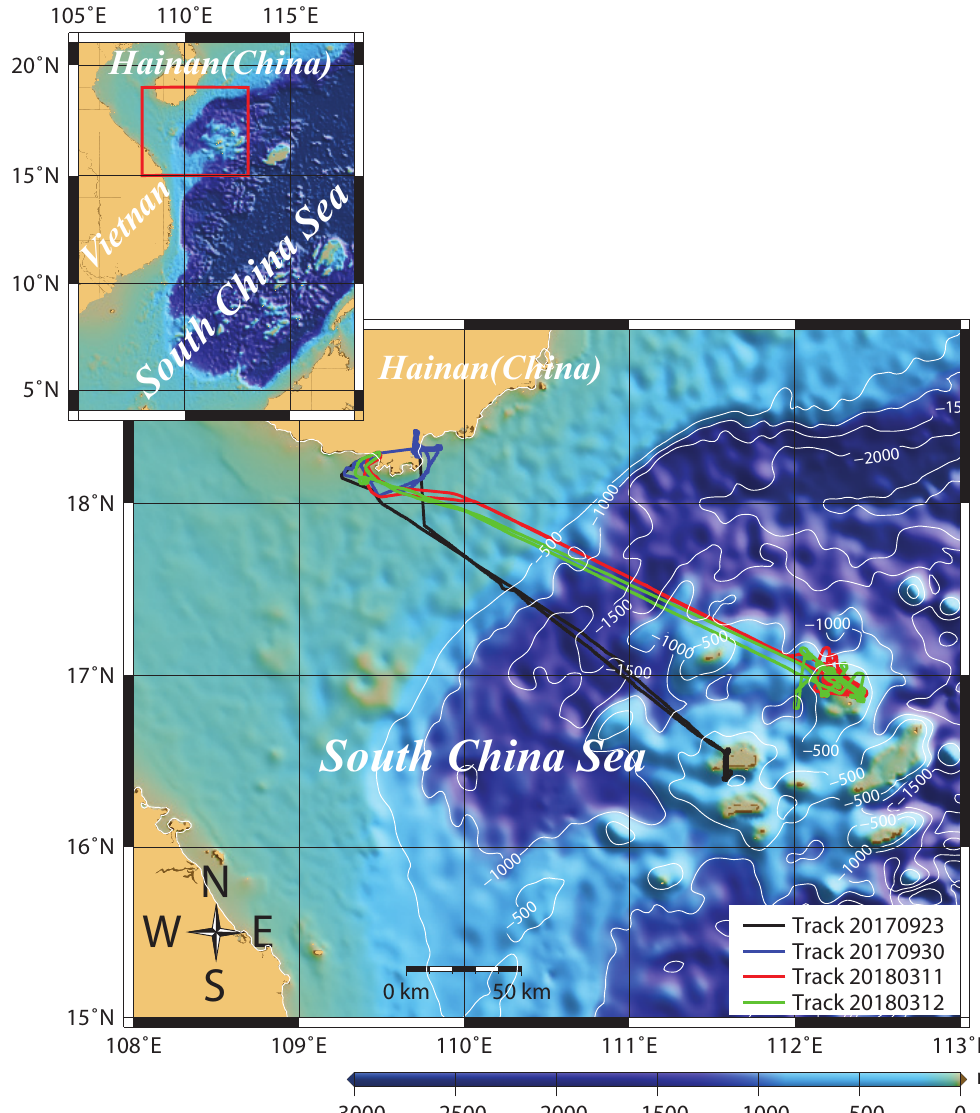
Figure 2. LiDAR flight experiments in the SCS. The color lines are flight tracks of airborne LiDAR taken on 23 September ( black ) and 30 September ( blue ), 2017, and on 11 March ( red ) and 12 March ( green ), 2018.